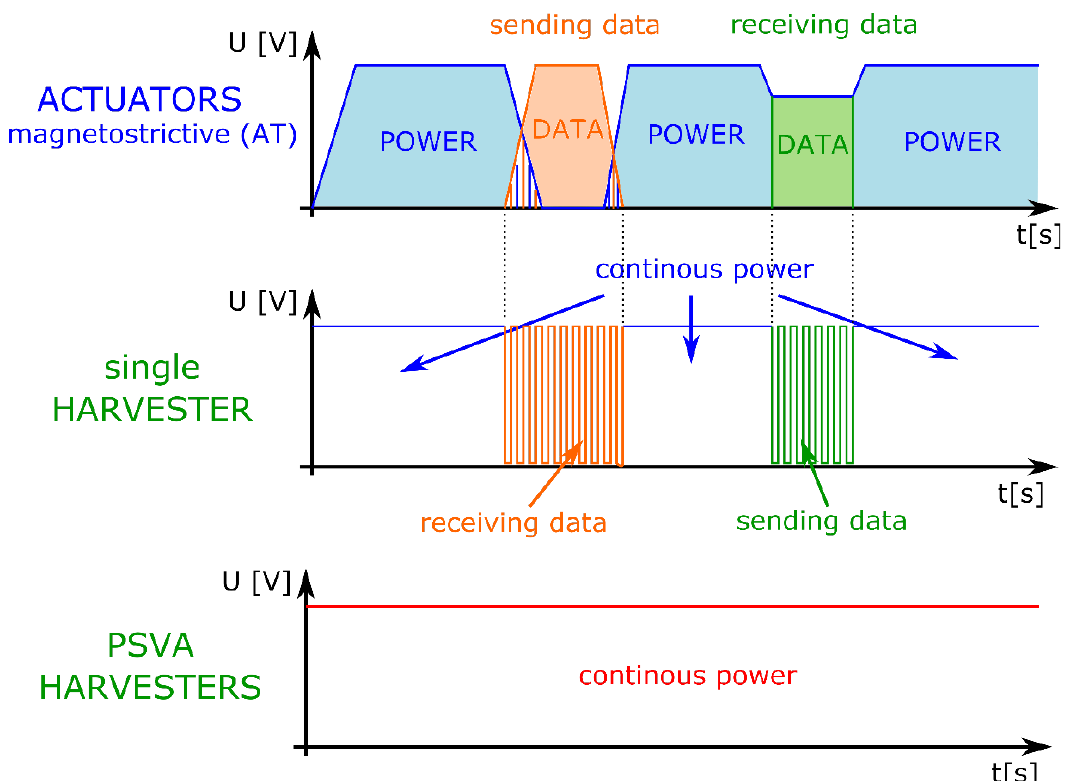
Figure 6. Data transmission and receiving information for PSVA.